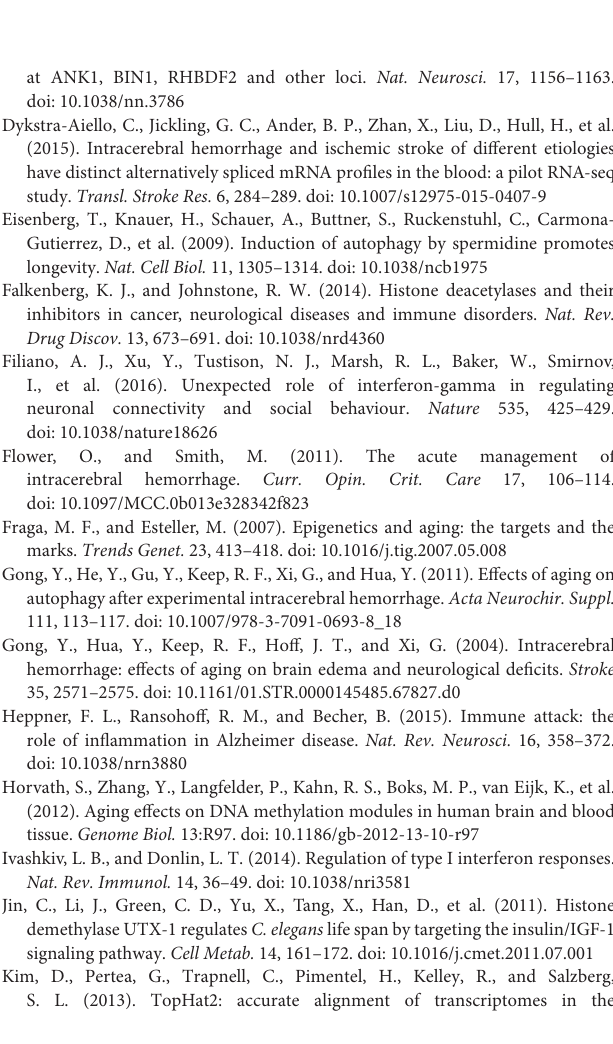
Supplementary Table 1 | Summary of RNA-seq and ChIP-seq data. Supplementary Table 2 | The overlapped peaks between two biological replicates of ChIP-seq samples. Supplementary Table 3 | Summary of the peaks and genes analyzed by MACS2 software. Supplementary Table 4 | Primer sequences for